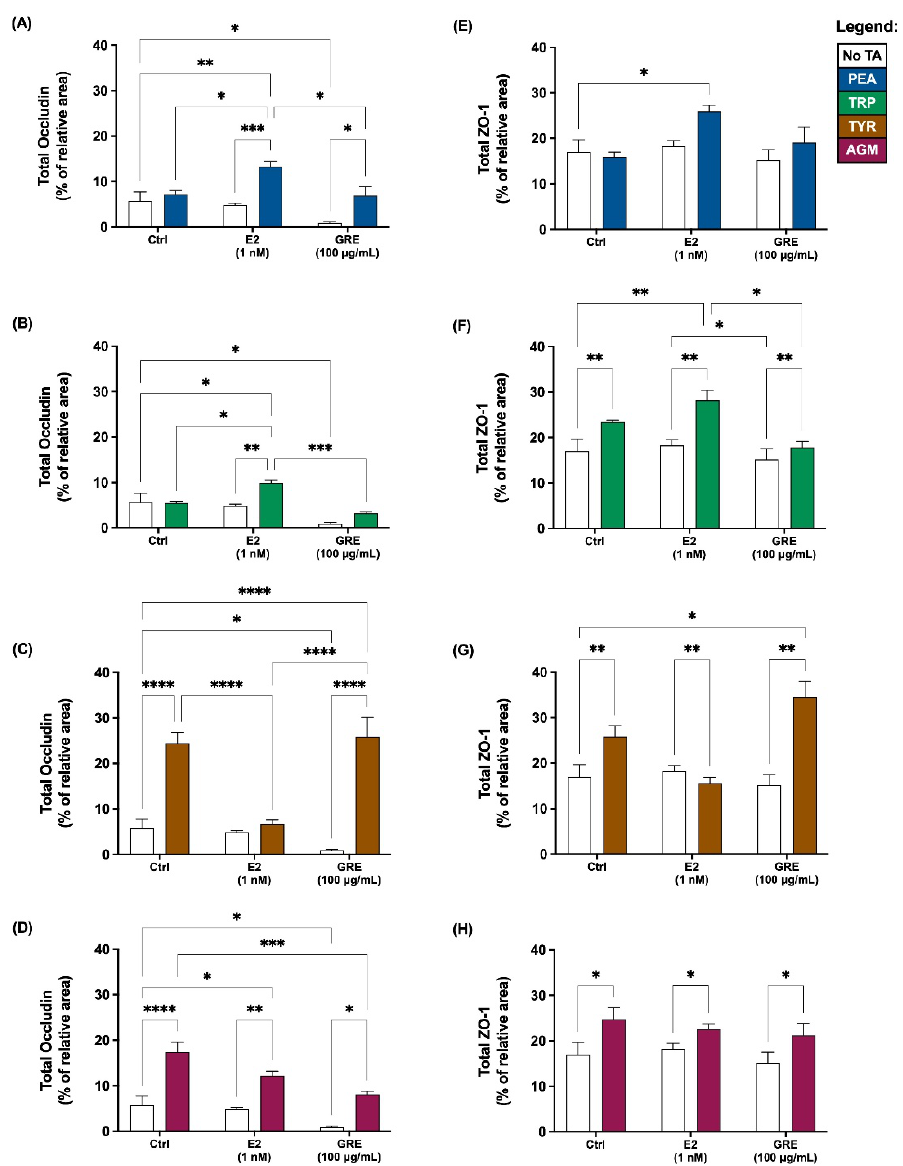
Figure 1. Effects of green rooibos extract (GRE) and 17 β -estradiol (E2) on the percentage of relative area of imaged HT-29 cell monolayer that stained positive for tight-junction proteins occludin ( A – D ) and ZO-1 ( E – H ) following selected TA exposure (200 ng/mL): ( A , E ) β -phenethylamine (PEA), ( B , F ) tryptamine (TRP), ( C , G ) ρ -tyramine (TYR) and ( D , H ) agmatine (AGM). Data are represented as mean (% of total imaged area) ± SEM. Statistical analysis: 2-way ANOVAs with Tukey’s multiple comparison tests: * = p < 0.05, ** = p < 0.01, *** = p < 0.001, **** = p < 0.0001.